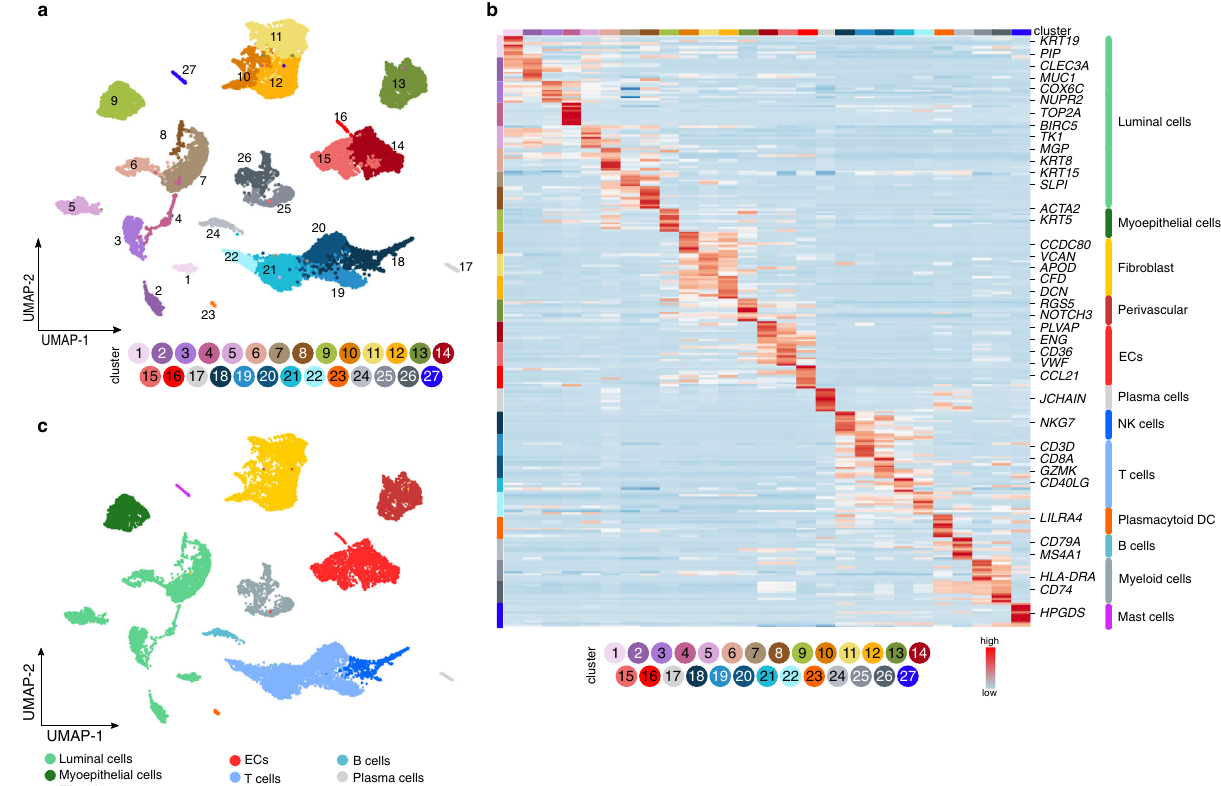
Fig. 3 | Single cell taxonomy of the breast microenvironment. a UMAP-plot of the subclustering of 18,082 cells from tumoral ( n =9) and matched peri-tumoral ( n =8) BC samples (TME and pTME respectively, composed of all cell types). b Heatmap of the expression levels of the top-10 marker genes in all 27 stromal